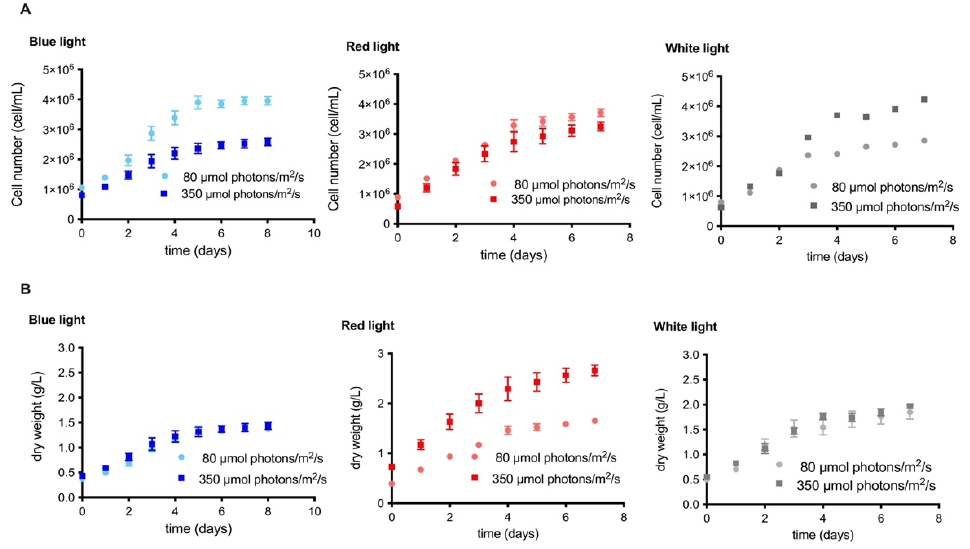
Figure 1. Kinetics of the irradiance effect for each experiment with blue, red, and white light in the MCH-35 microalgae grown at 80 µmol photons/m 2 /s and 350 µmol photons/m 2 /s. ( A ) Cell growth curve (cells/mL) and ( B ) dry weight curve (g/L). The data represents the average of four independent measurements. Data are expressed as the mean ± SD ( n = 4).